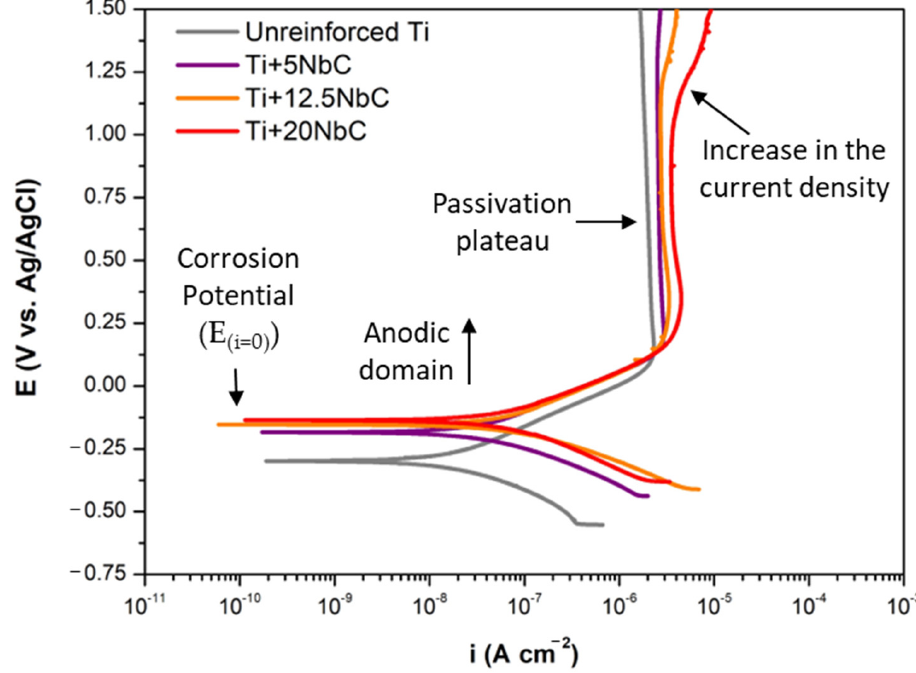
Figure 4. Potentiodynamic polarization curves for unreinforced Ti and all composites in PBS at 37 °C.